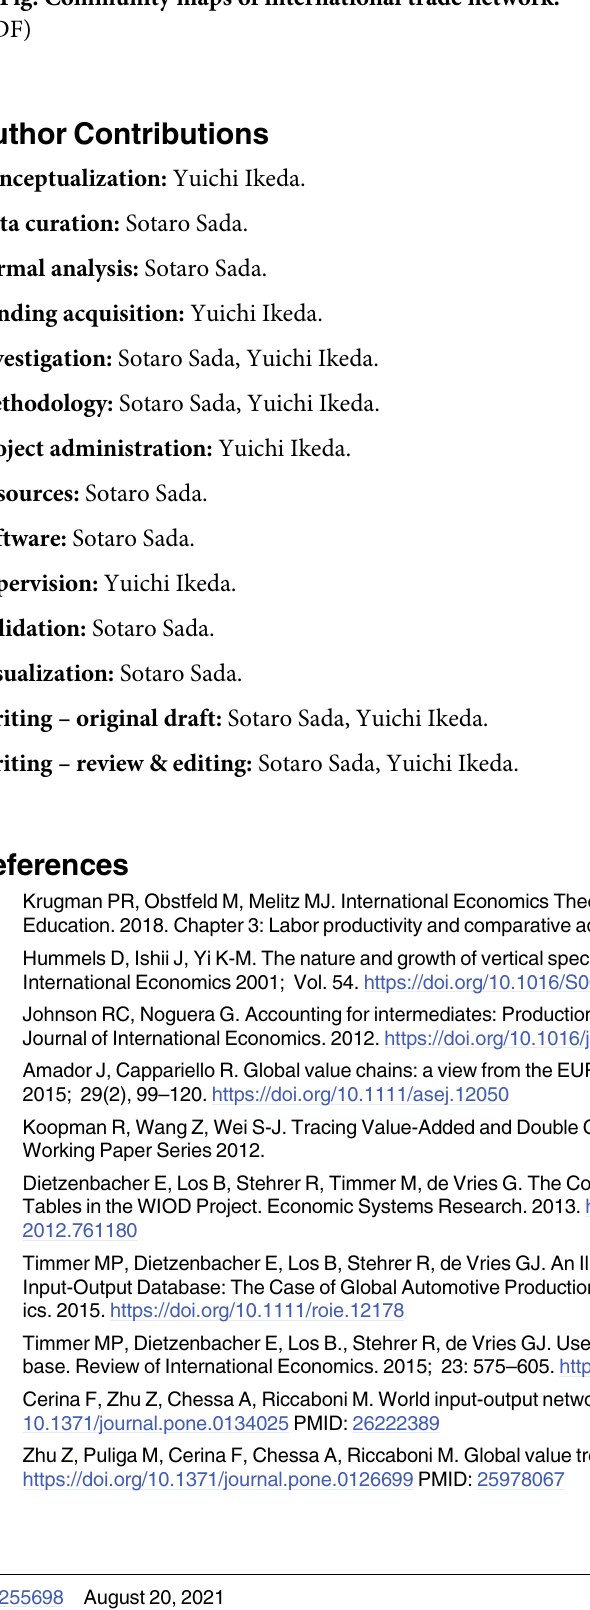
S3 Table. Number of communities of international trade networks. (PDF) S1 Fig. Community maps of international trade network.